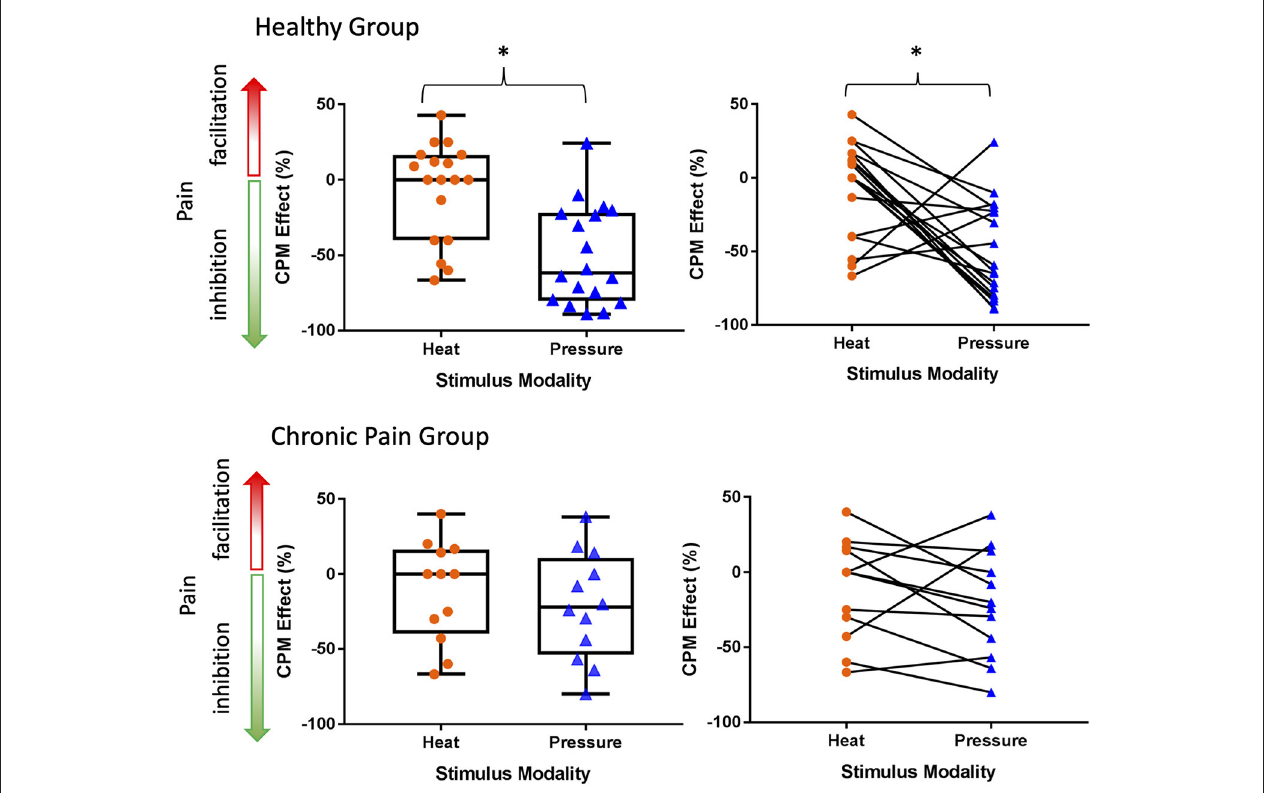
FIGURE 2 | The CPM effect only significantly differs between stimulus modalities in the healthy group. In both the healthy group and chronic pain group the inhibitory CPM effect is more pronounced using pressure than heat stimuli. Line within box is the median, edges of box are 25th to 75th percentiles, and the whiskers denote the maximum and minimum. Asterisks denote significant difference within-subjects ( p <